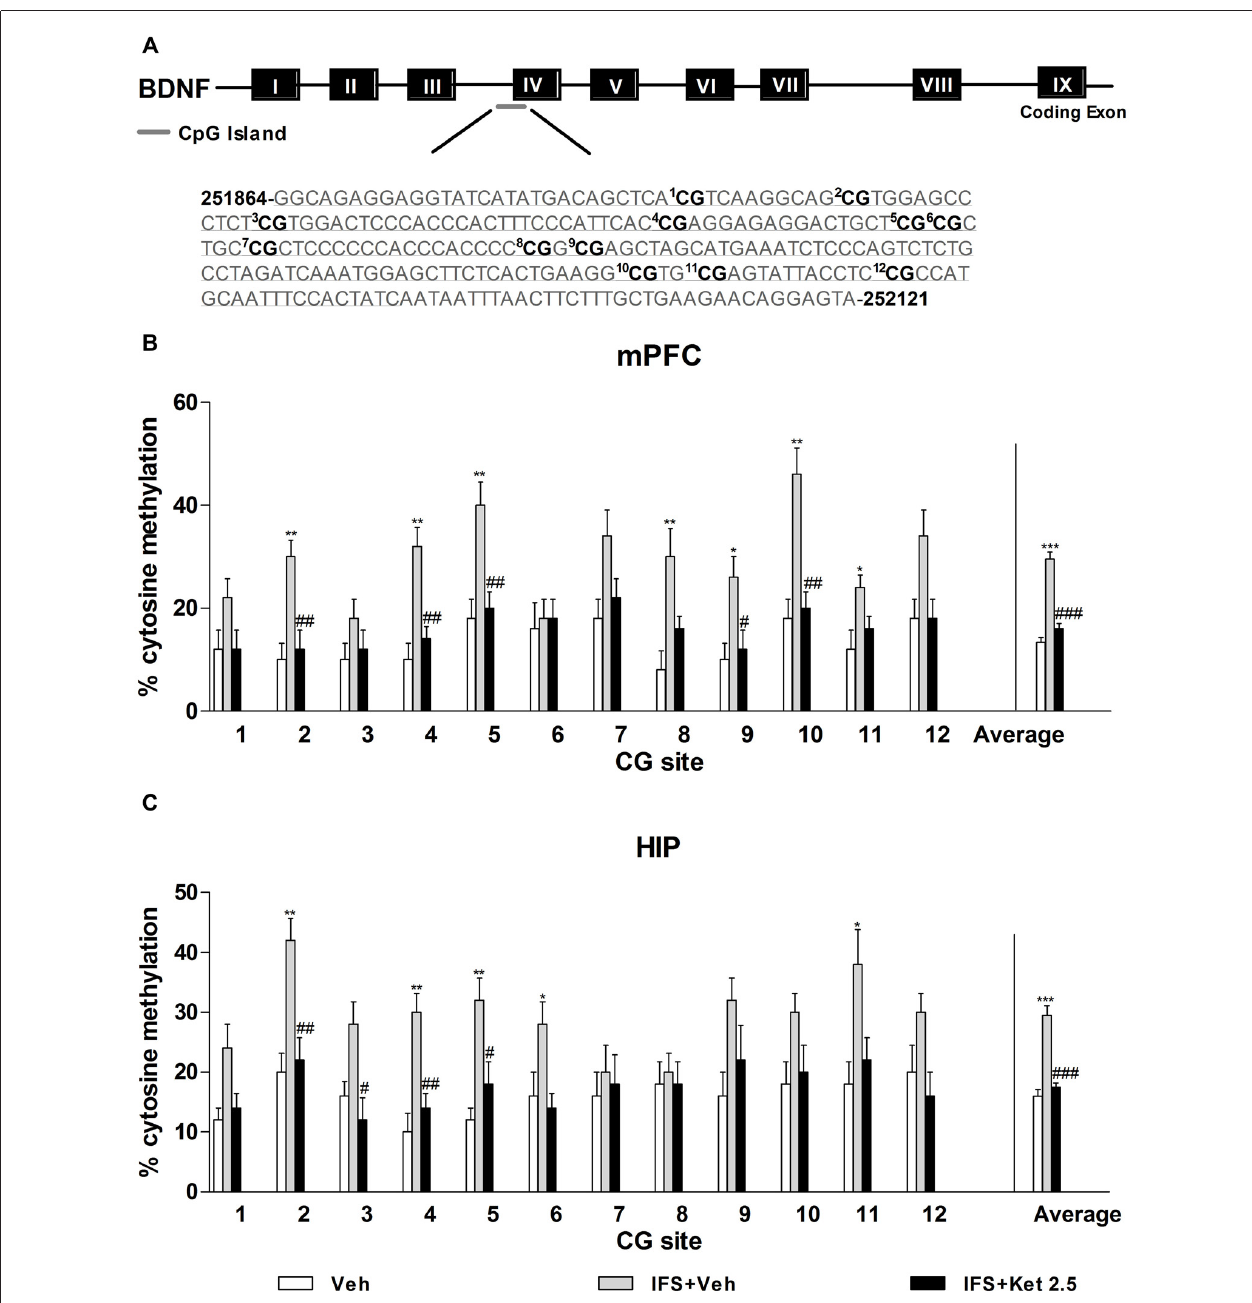
FIGURE 8 | Ketamine on the Bdnf DNA methylation in the IFS mice. (A) Bisulfite sequencing analysis performed on 12 CpG sites near the transcription initiation site of Bdnf exon IV show percentage of cytosine residues that were methylated with fear- conditioning. (B,C) IFS mice displayed higher percentage of methyl cytosine residues at specific CpG sites in the mPFC and HIP, which were demethylated after ketamine treatment. Data are presented as mean ± SEM ( n = 5 in per group). ∗ P < 0.05, ∗∗ P < 0.01, ∗∗∗ P < 0.001 compared with the Veh group; # P < 0.05, ## P < 0.01, ### P < 0.001 compared with the IFS + Veh